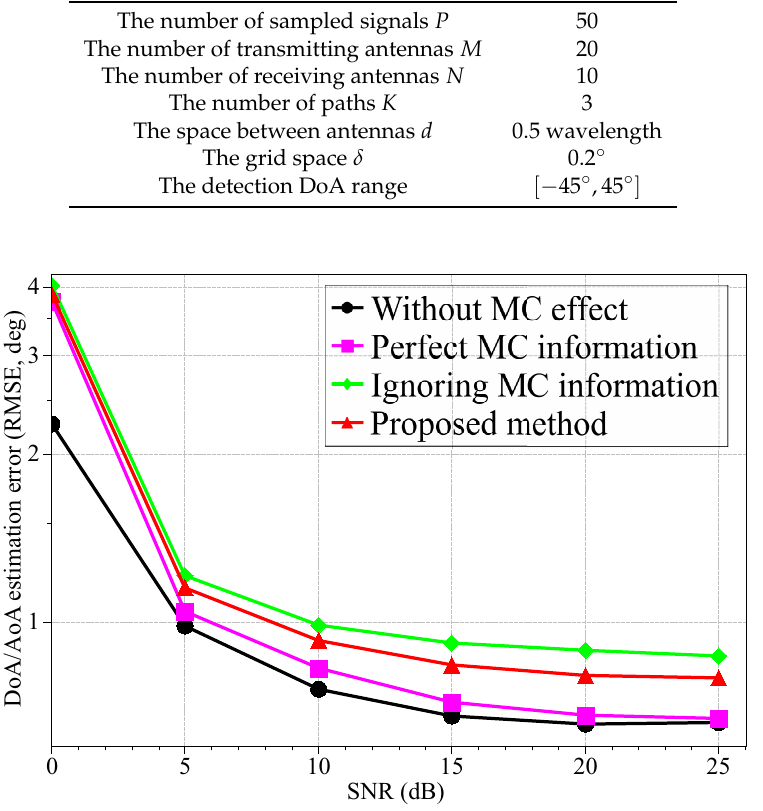
Figure 2. The DoD/DoA estimation performance with different SNRs (the MC effect is − 15 dB between adjacent